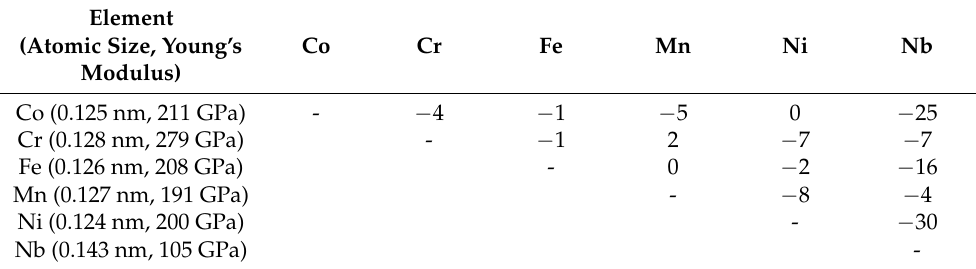
Table 3. Mixing enthalpies of different atom pairs ∆ H mix